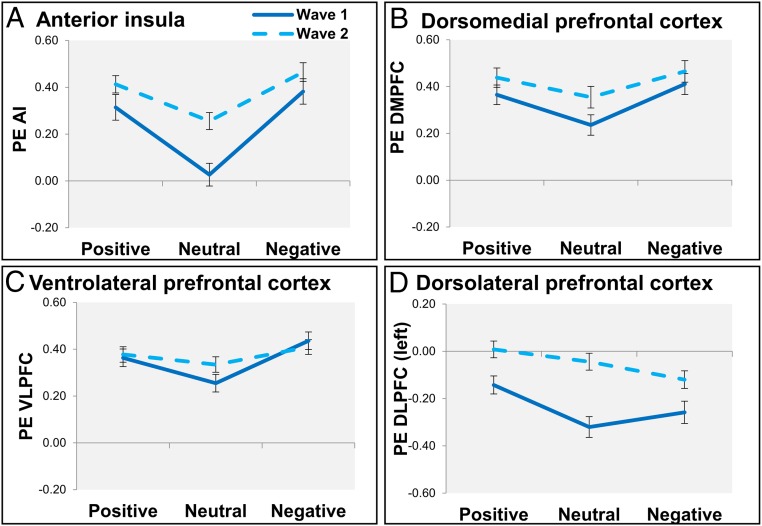
Neural activation after positive, neutral, and negative social feedback at W1 (solid dark blue lines) and W2 (dotted light blue lines) for the AI (A), the DMPFC (B), the VLPFC (C), and the left DLPFC (D).